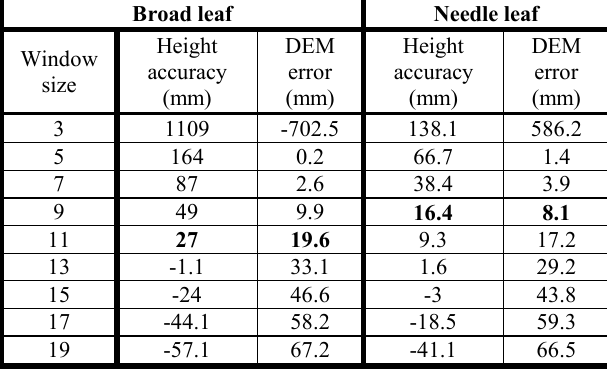
Table 2: Height accuracy and DEM error obtained in tworegions: broad and needle leaves species Broad leaf Needle leaf